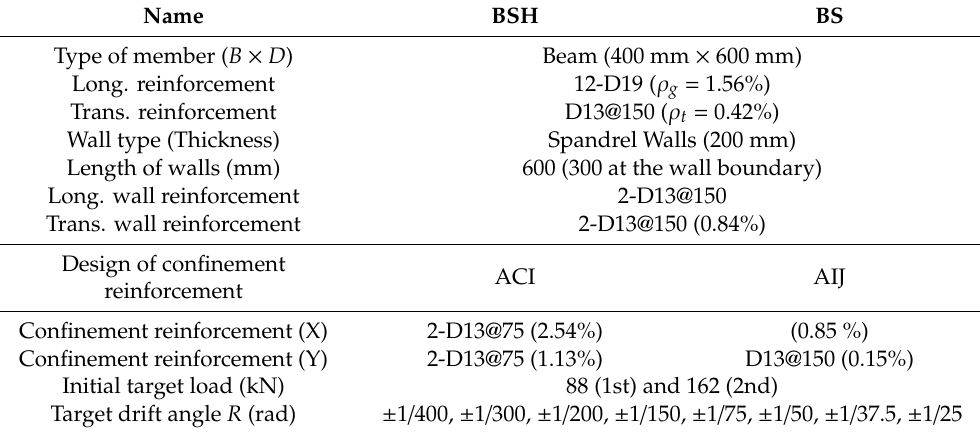
Figure 3. Stress–strain relation: ( a ) concrete of BSH and BS; ( b ) steel bar D13; ( c ) steel bar D19. Table 1. Details of specimens.